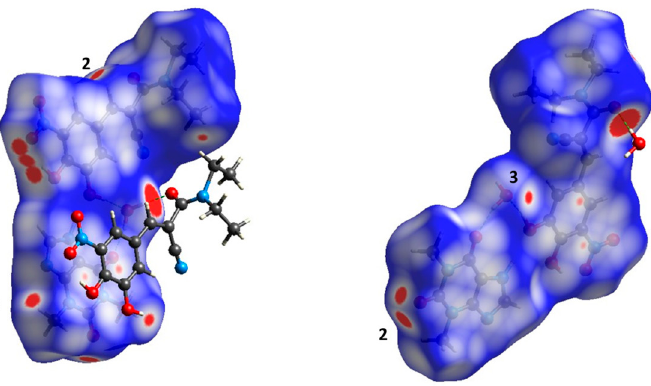
Figure 4. Hirshfeld Surface mapped over d norm for ENT-THP-water 1:1:1 cocrystal in different ori- entations.